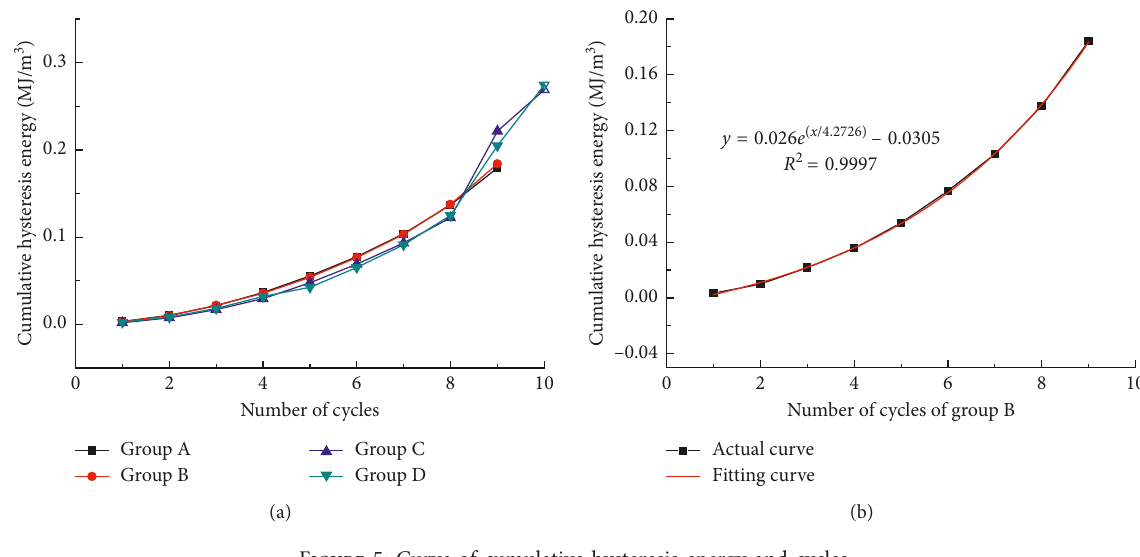
Figure 5: Curve of cumulative hysteresis energy and cycles. Table 2: Elasticity modulus of loading and unloading (GPa). Group A